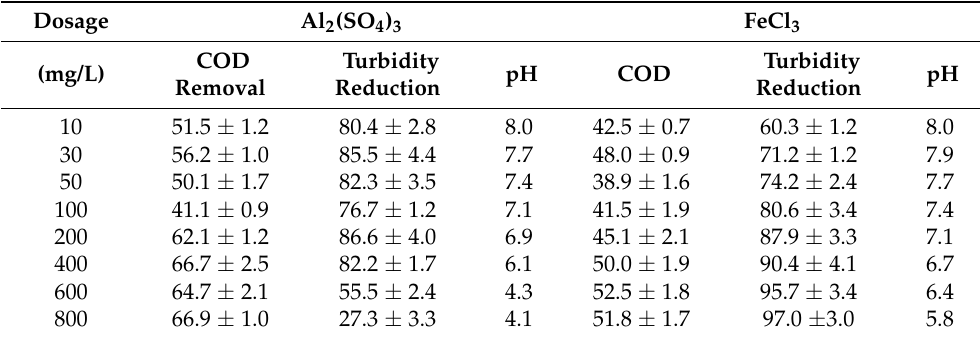
Table 6. Results of water quality improvement for the coagulation experiments (COD removal